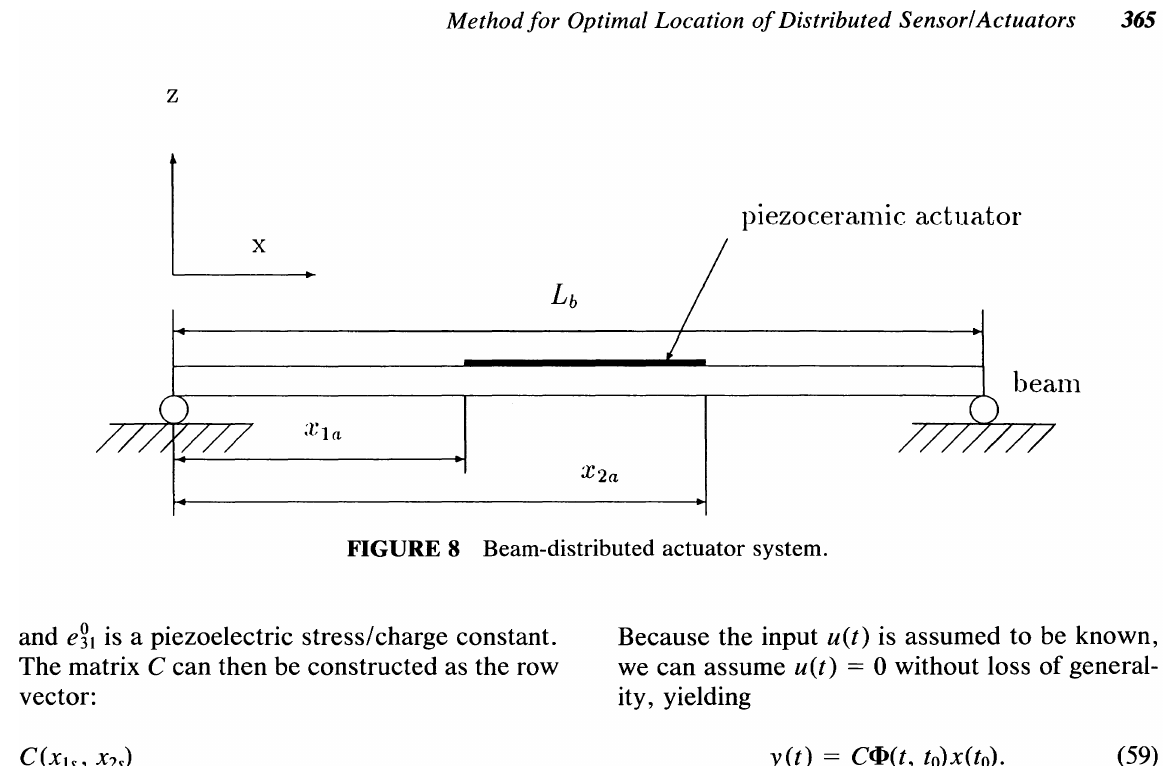
FIGURE 8 Beam-distributed actuator